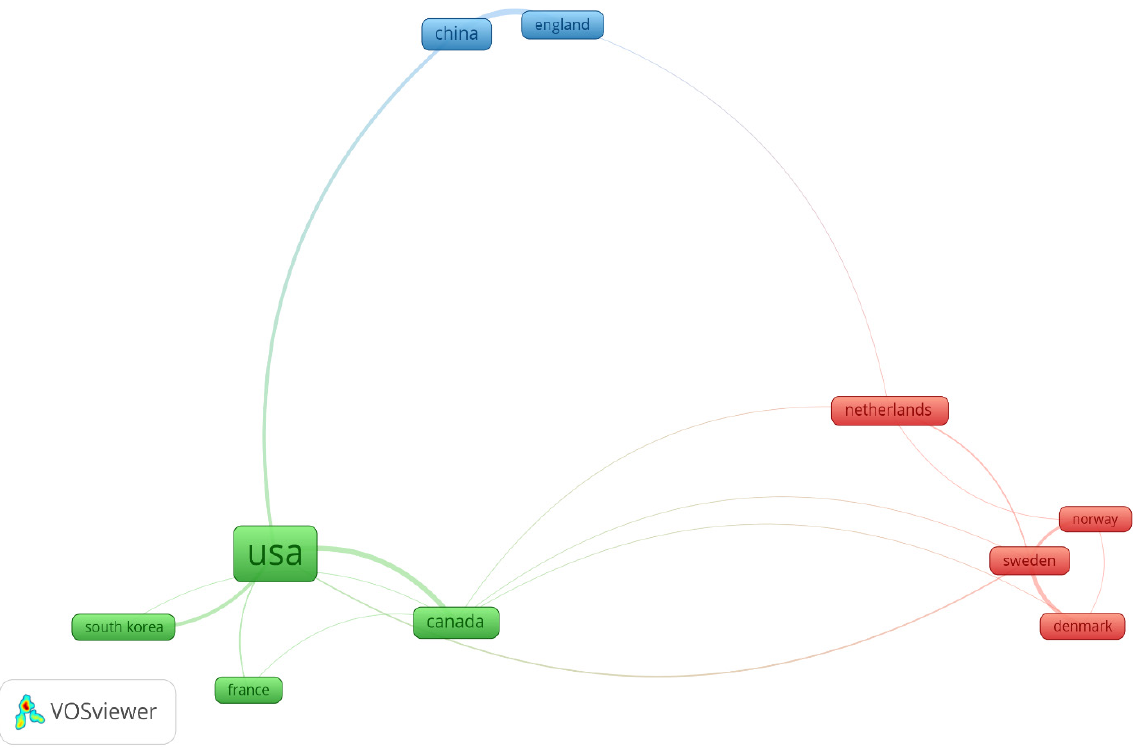
Figure 4. Visualization of co-authorship by country.